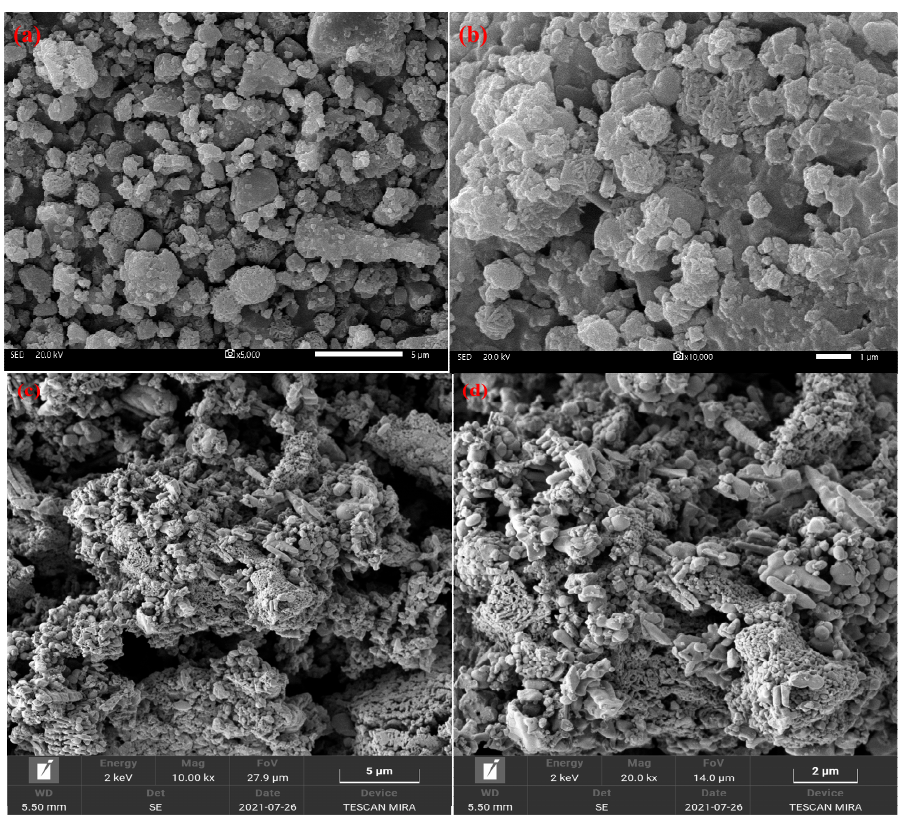
Figure 12. Microstructure of different leaching residues (( a , b ): alkaline leaching slag; ( c , d ): acid leaching slag).